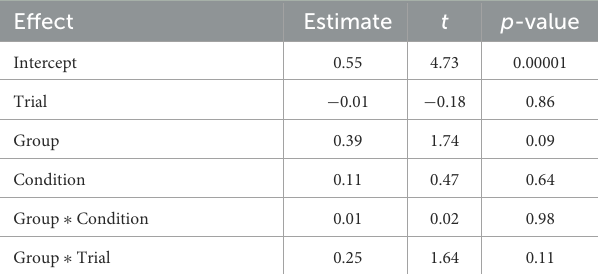
TABLE 4 Outcomes of the linear mixed-effects model for Word2.